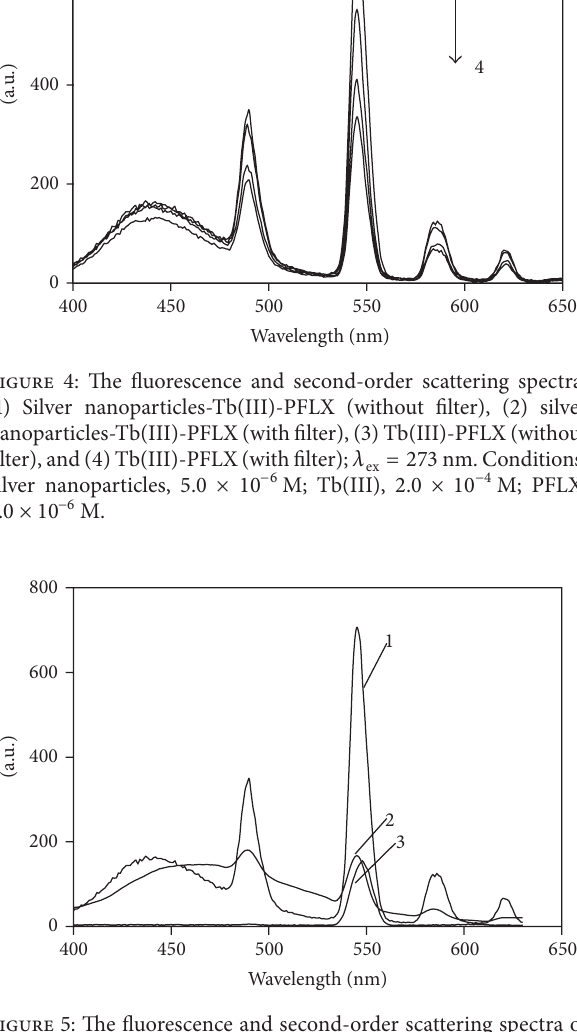
Figure 5: The fluorescence and second-order scattering spectra of PFLX and OFLX. (1) Silver nanoparticles-Tb(III)-PFLX, (2) silver nanoparticles-Tb(III)-OFLX, and (3) silver nanoparticles-Tb(III). Conditions: silver nanoparticles, 5.0×10 −6 M; Tb(III), 2.0×10 −4 M; PFLX and OFLX, 1.0 × 10 −6